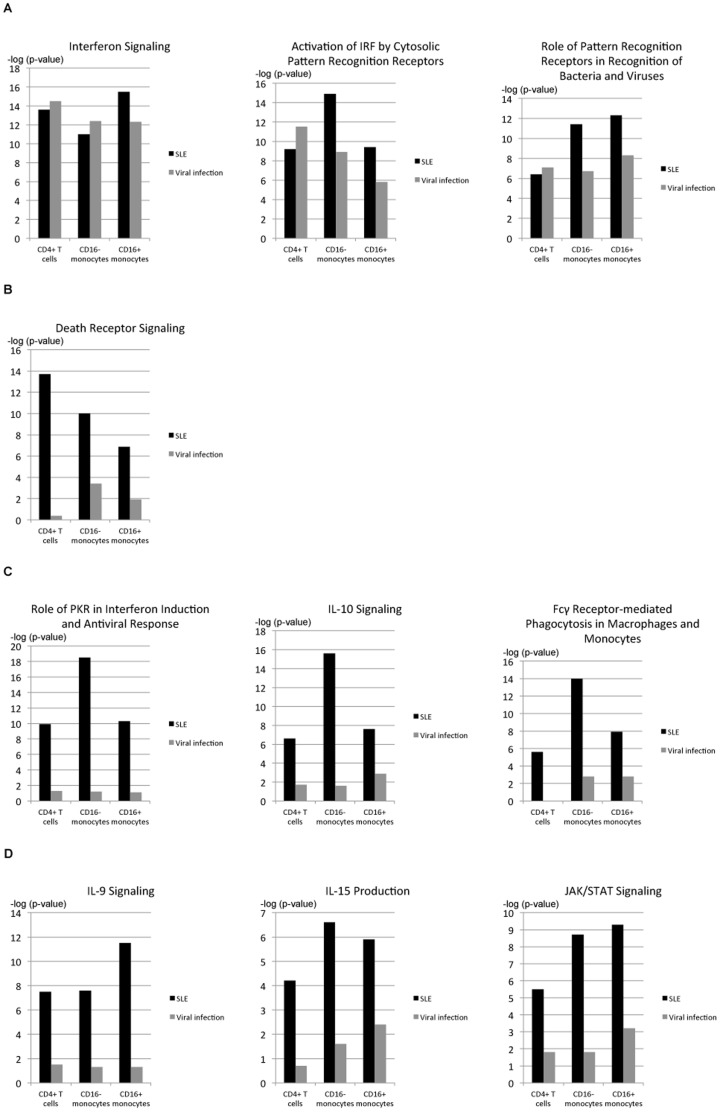
Comparison of the enrichments of genes in the top-ranked canonical pathways in SLE patients and immunised healthy donors.CD4+ T cells, CD16− monocytes and CD16+ monocytes from patients with SLE and healthy donors immunised with the yellow fever vaccine (designated as “Viral infection”) were analysed using the Ingenuity Pathway Analysis (IPA) tool. (A) Commonly observed pathways in all compared groups. (B) Dominantly observed pathways in the CD4+ T cells from the SLE patients. (C) Dominantly observed pathways in the CD16− monocytes from the SLE patients. (D) Dominantly observed pathways in the CD16+ monocytes from the SLE patients.